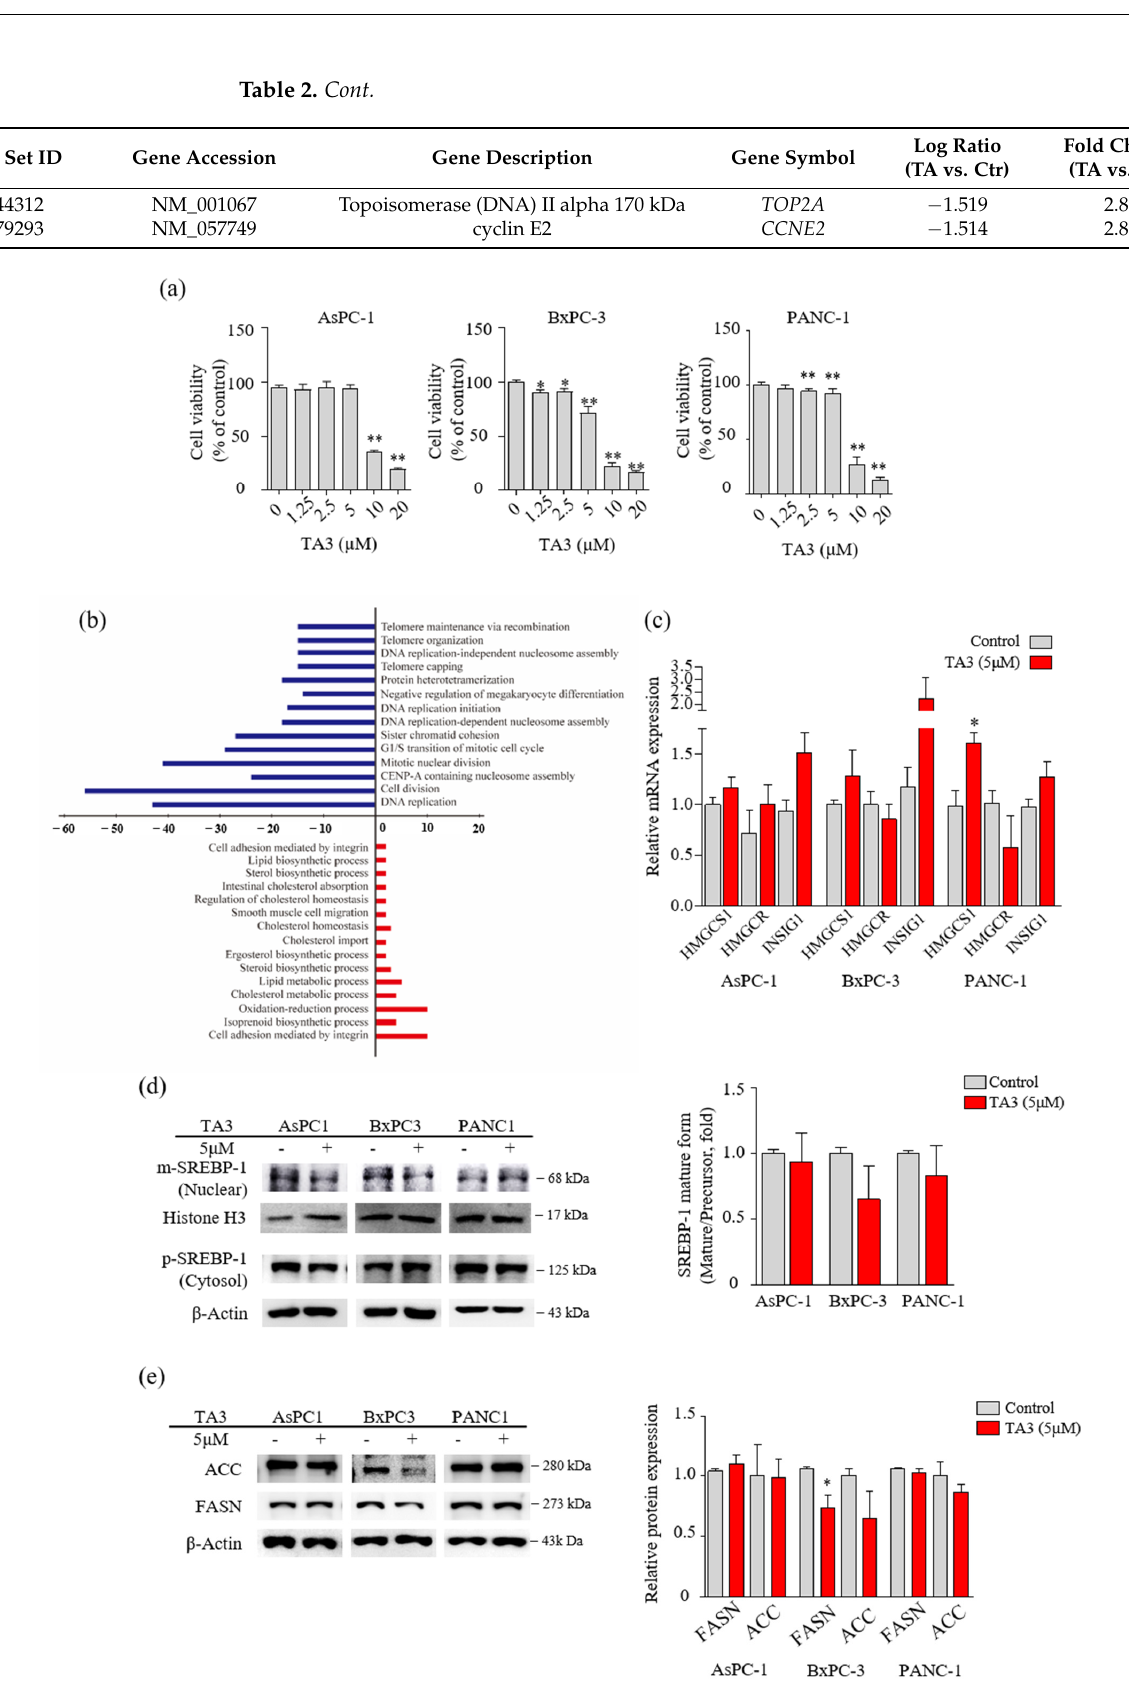
Figure 1. TA3 affected the regulation of enzymes involved in lipid metabolism in BxPC3 cells. ( a ) The cells were treated with TA3 at various concentrations for 24 h. The cell viability was measured